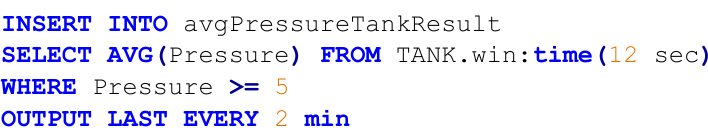
Figure 7. Example of Event Processing Language (EPL) rule.